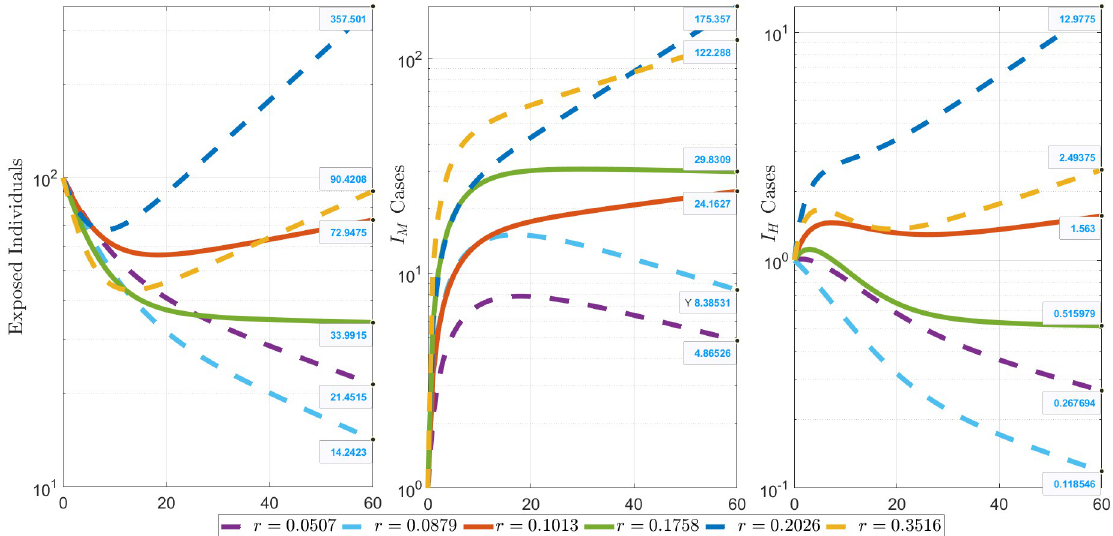
Fig 5. The different simulations of r values and its effect on the transmission dynamics in logscale. These show the epidemic curves using the smallest estimated r = 0.1013, biggest estimated r = 0.1758, and scenarios where the r values are half ( r = 0.0507, r = 0.0879), and twice the corresponding estimates ( r = 0.2026, r = 0.3516). Solid curves are the simulations using r values from the model estimates, while the dashed curves are simulations using arbitrarily chosen r values for scenario